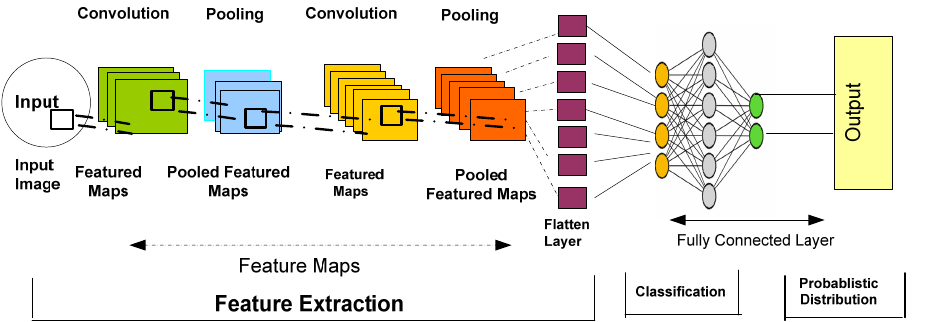
Figure 3. LSTM model.